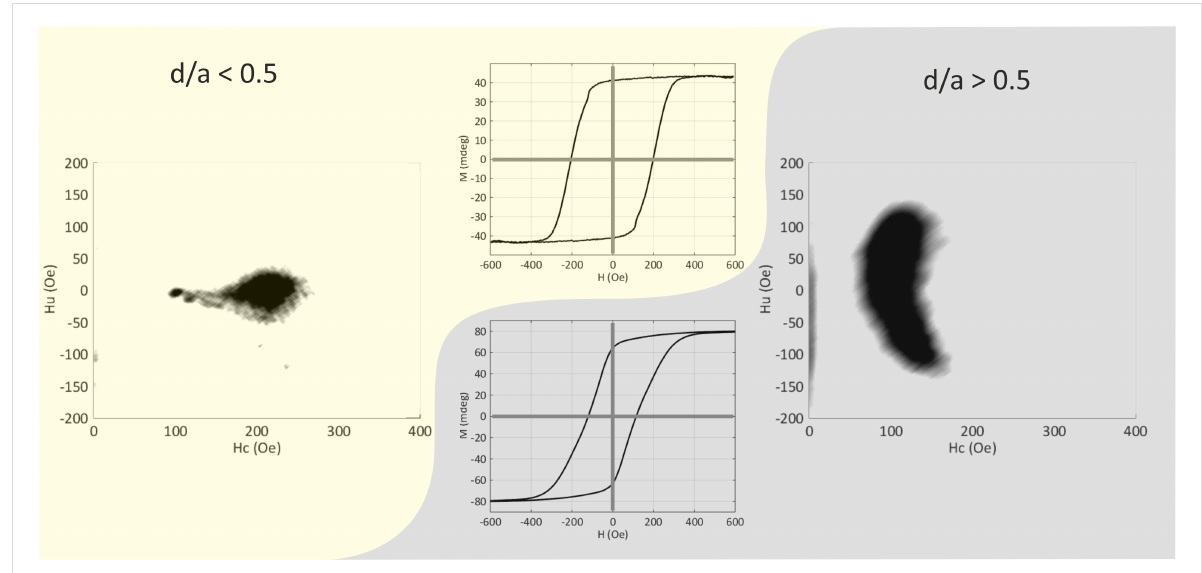
Figure 12: Major hysteresis loops and FORC diagrams of two hexagonal antidot lattices in out-of-plane magnetized GdFe films. Both feature the same hole spacing a = 200 nm, but the hole diameter d is 95 nm and 120 nm, respectively. Reproduced with permission from [59], copyright 2015 IEEE.